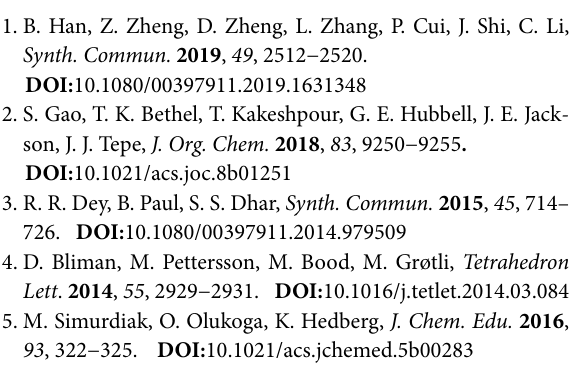
Tabari et al.: Magnetic Nanoparticles Linked ...